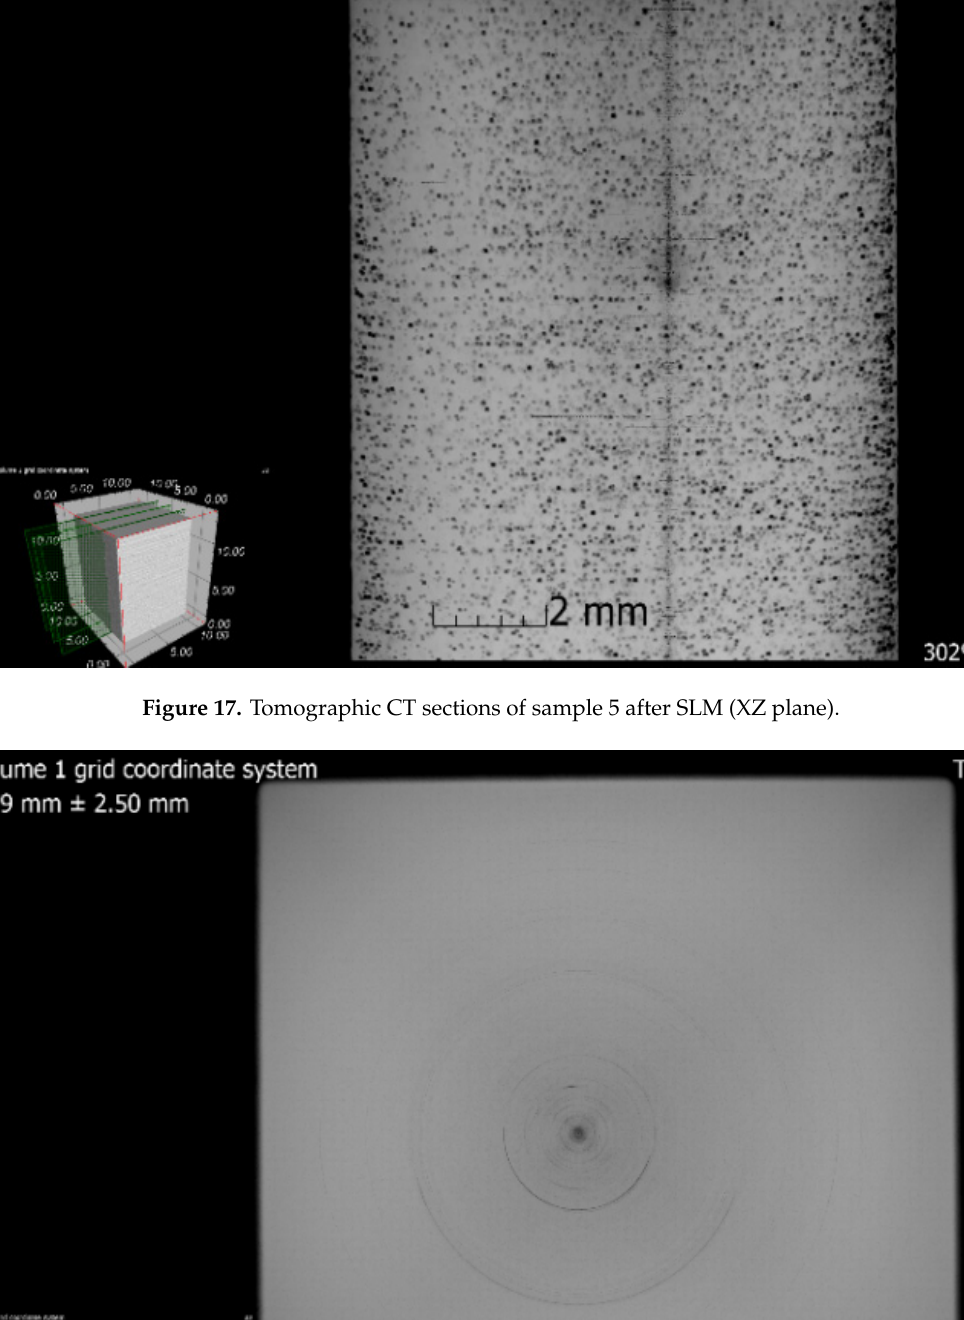
Figure 16. Tomographic CT sections of sample 5 after SLM (XY plane).